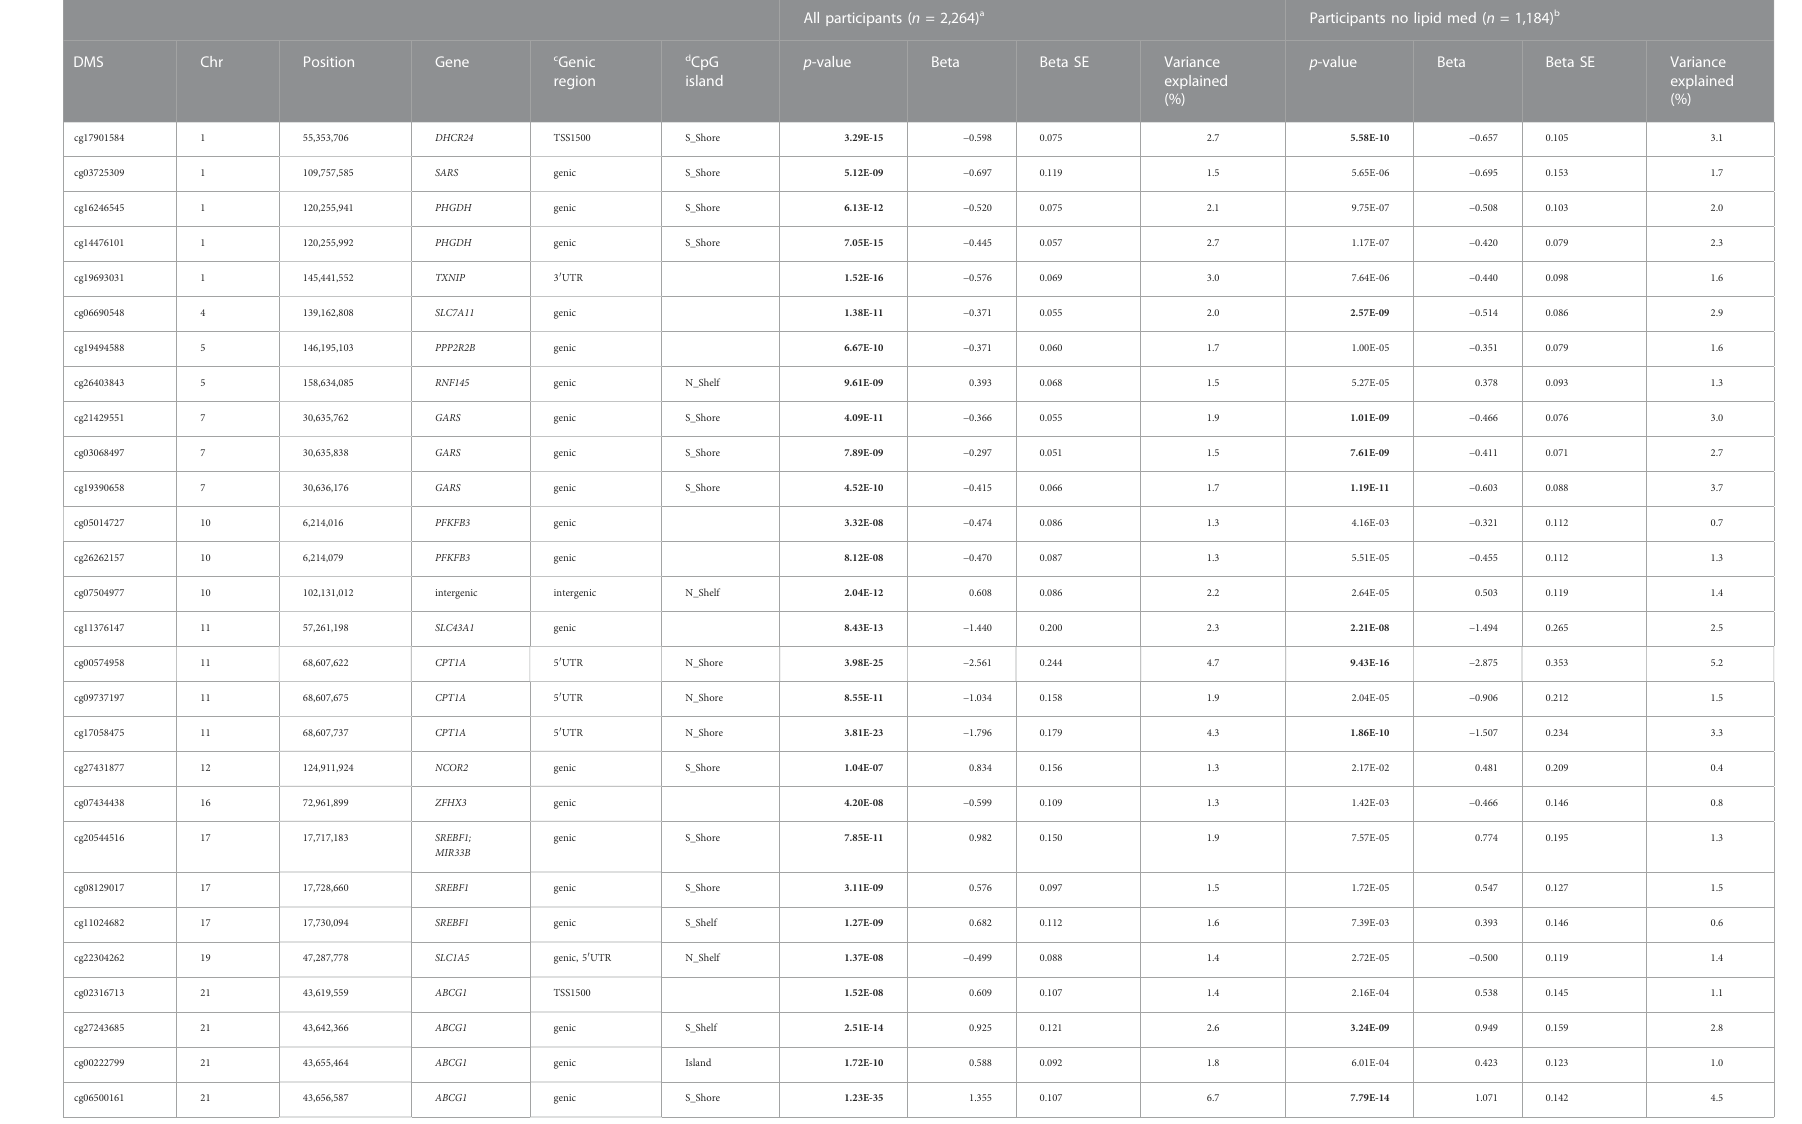
TABLE 1 Epigenetic variants associated with fasting plasma triglyceride of the Framingham Heart Study at Exam 8.